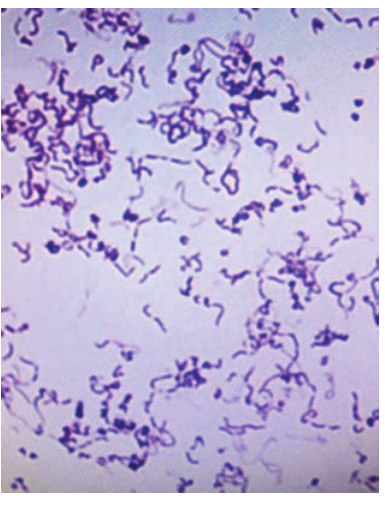
Figure 2. Microscopic findings of E. rhu- siopathiae. Gram positive, rod-shaped bac-